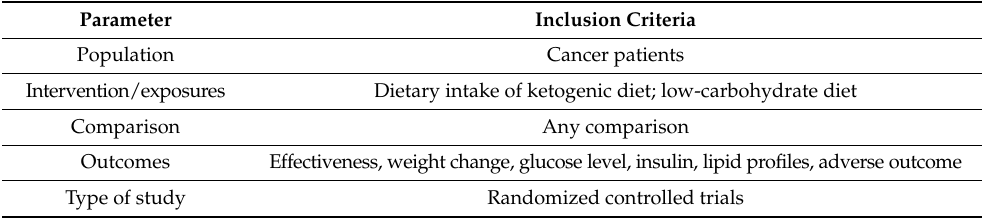
Table 1. PICOS criteria for inclusion and exclusion of